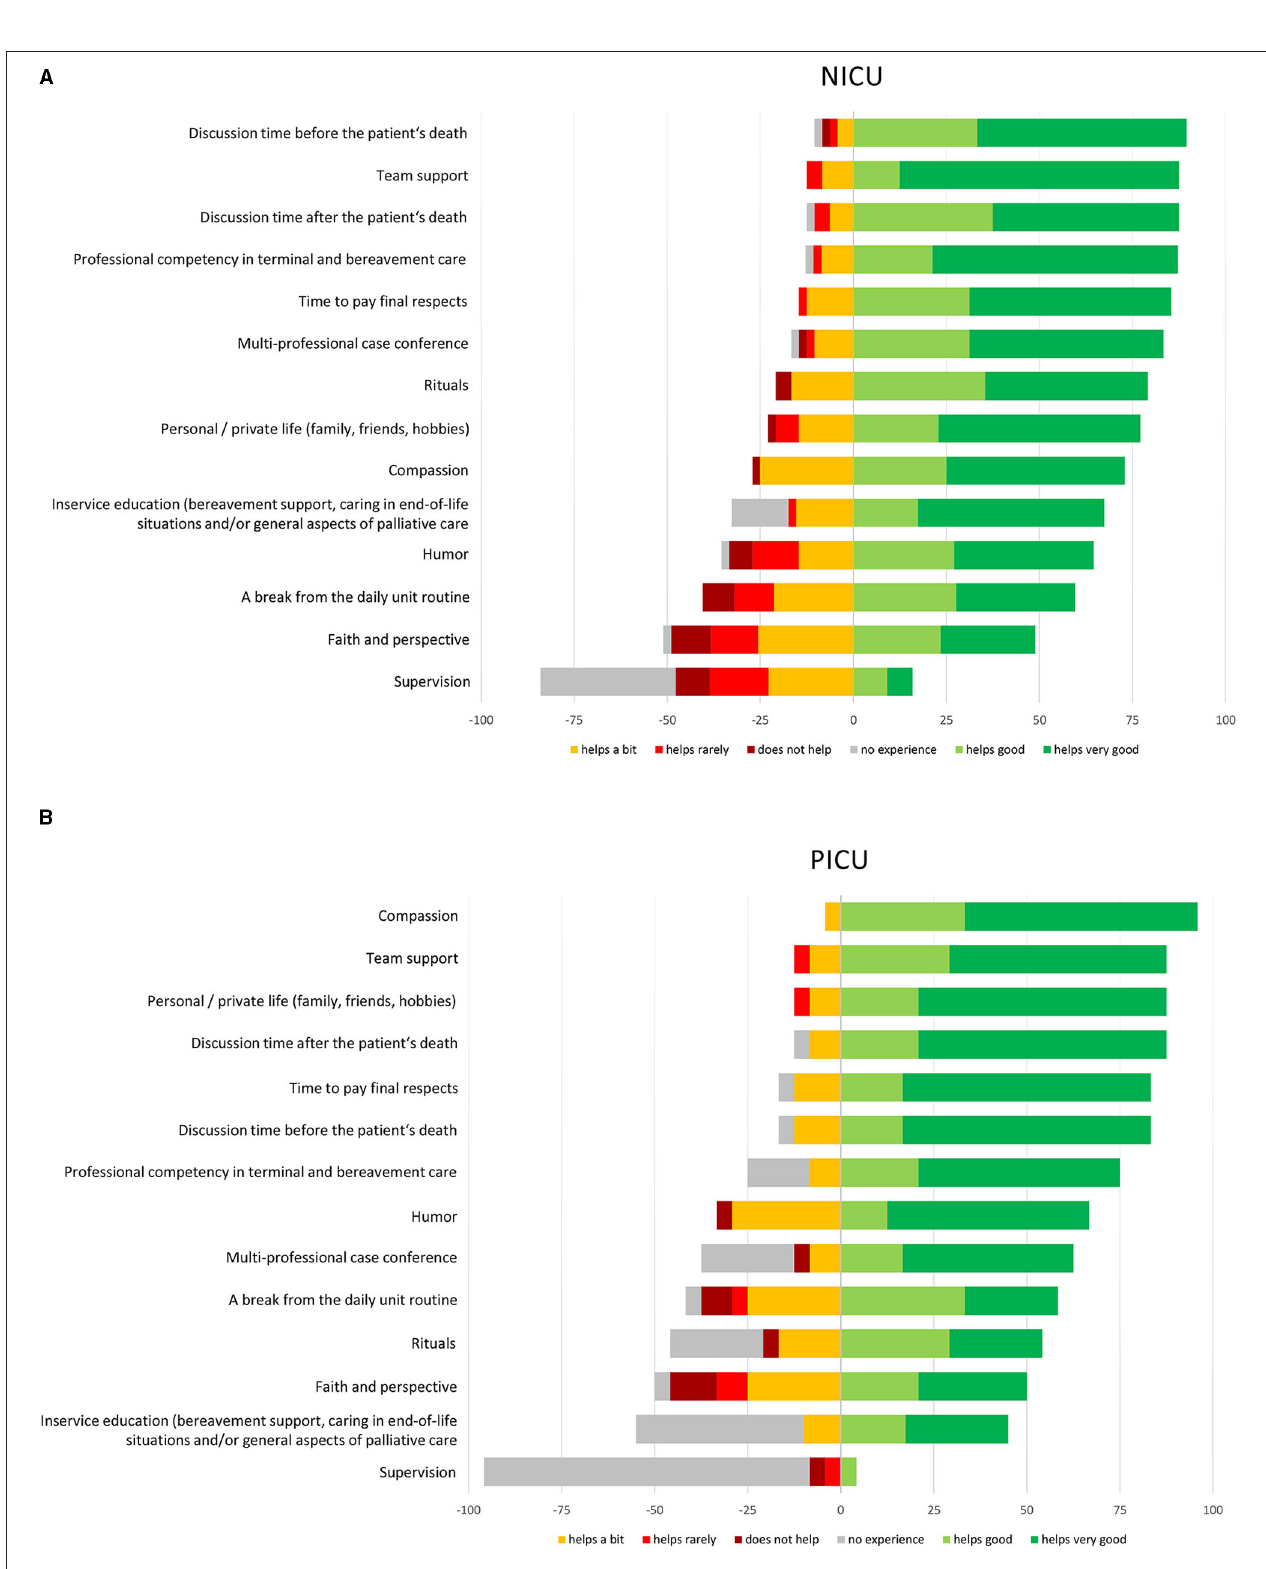
FIGURE 3 | Coping mechanisms in end-of-life care as self reported by (A) NICU staff and by (B) PICU staff (%). All questions to be rated by using a six-point Likert Scale.